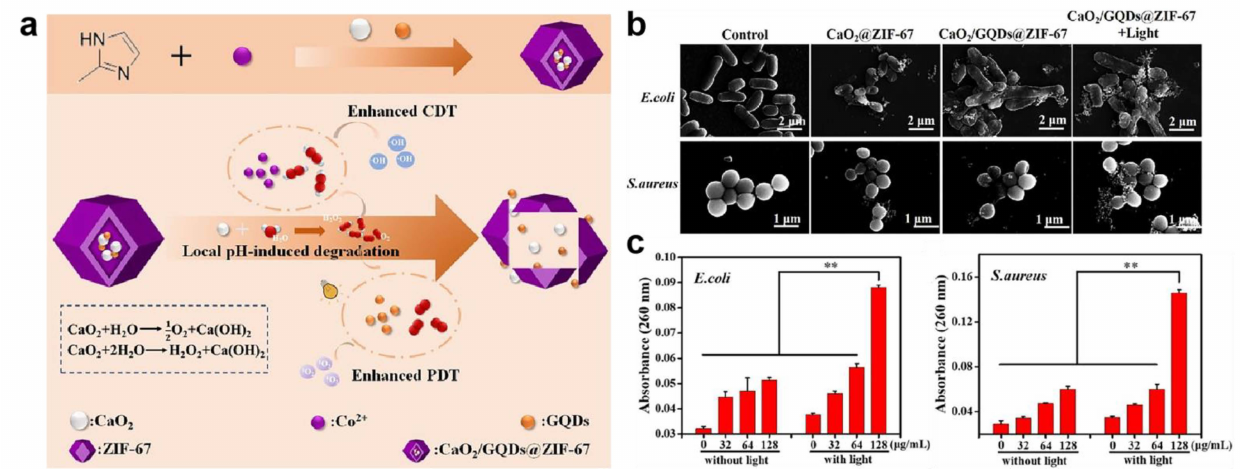
Figure 3. Cell membrane damage caused by zeolitic imidazolate framework-67 nanosystem (CaO 2 /GQDs@ZIF-67). ( a ) Schematic illustration for bacterial killing by CaO 2 /GQDs@ZIF-67. ( b ) Scanning electron microscope image of E. coli and S. aureus . ( c ) Nucleic acid leaking detec- tion of E. coli and S. aureus after CaO 2 /GQDs@ZIF-67 treatment. ** denotes p < 0.01. Reprinted with permission from Ref [73]. Copyright 2021 American Chemical Society.